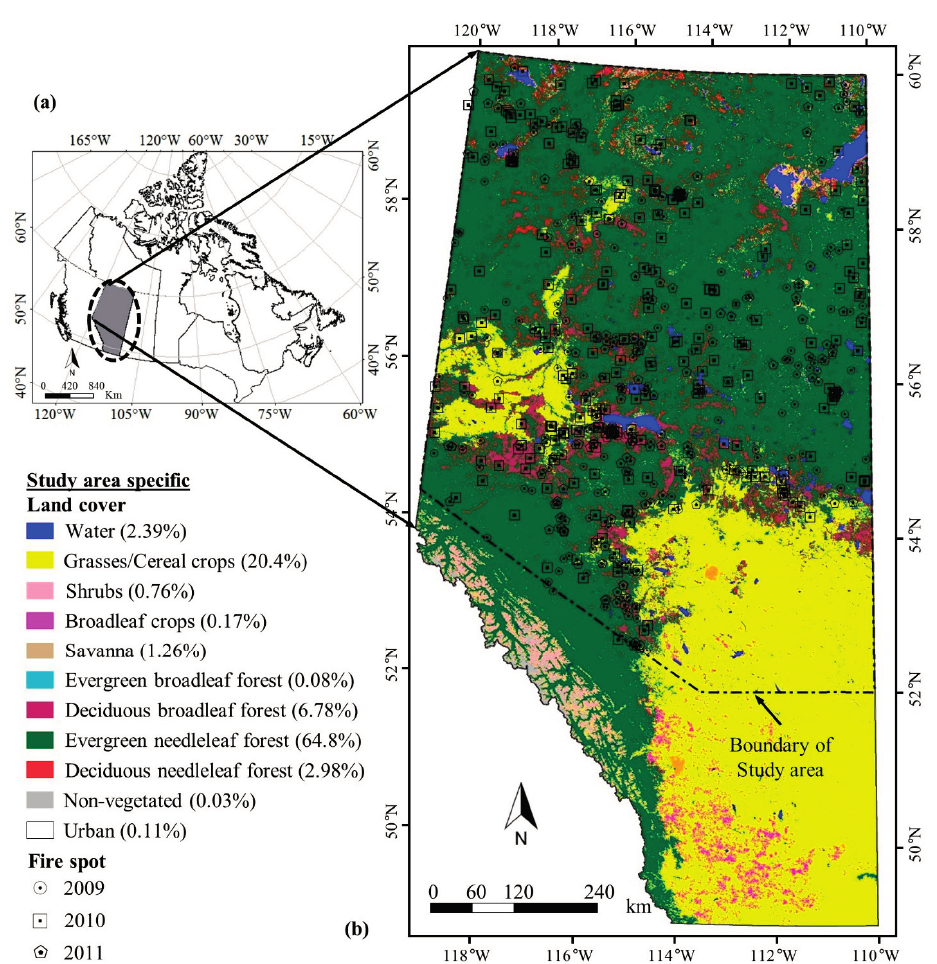
Figure 1. ( a ) Map of Canada showing the location of Alberta; and ( b ) spatial extent of the study area with dotted line shown over a MODIS-based annual land cover map of 2008 along with the fire occurrence spots available from Alberta ESRD during 2009–2011 fire